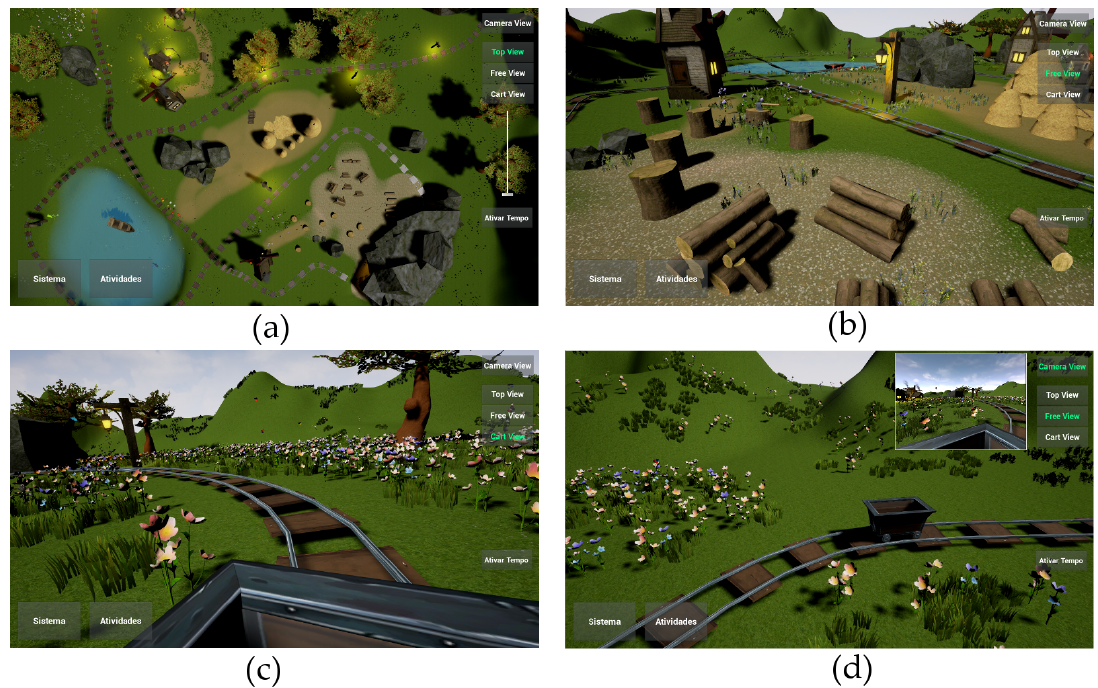
Figure 4. The images show the environment perspectives available at the therapis’s interface. The perspective selected is depicted by the green text of the selected button (top right hand corner). Image ( a ): Top view perspective. Notice that a slider is shown on the right to allow the therapist to zoom in or out. Image ( b ) Free view perspective. Image ( c ) Cart View perspective (same as the patient’s). Image ( d ) shows the Free view perspective, with the Camera view option activated. The smaller window show the patients view from within the